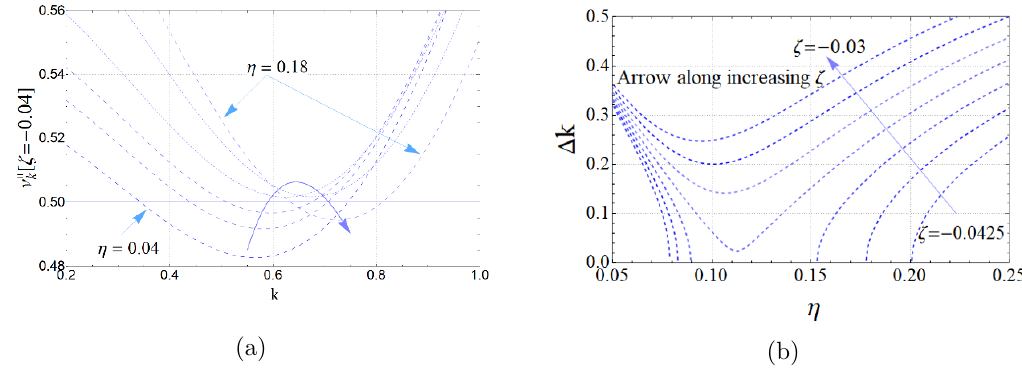
Figure 12. Left: the longitudinal channel exponent (cid:23) k shows nonzero spectral weight between k two nonzero values k + and k (cid:0) , both of which depend on (cid:17) . We call this a Fermi shell. The shell thickness (cid:1) k varies non-monotonically with (cid:17) . Right: for more negative values of (cid:16) , the spectral weight can disappear entirely for a certain range of (cid:17)